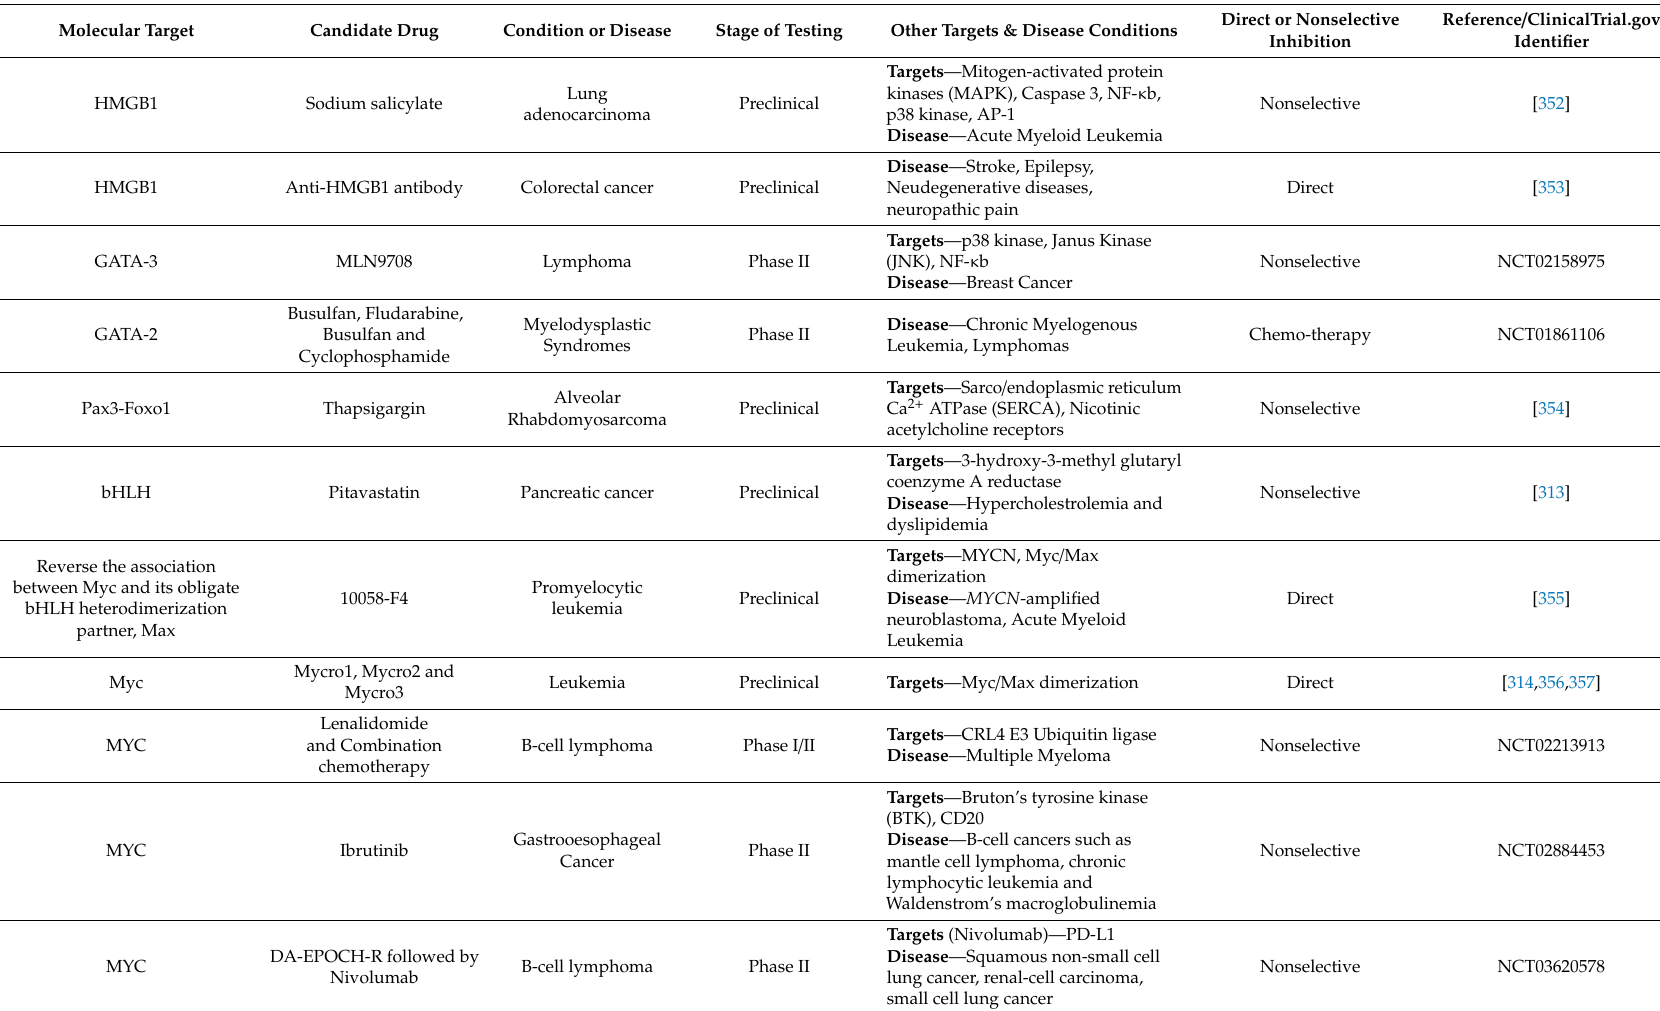
Table 2. Ongoing preclinical and clinical trials on transcription factor targets in di ff erent types of